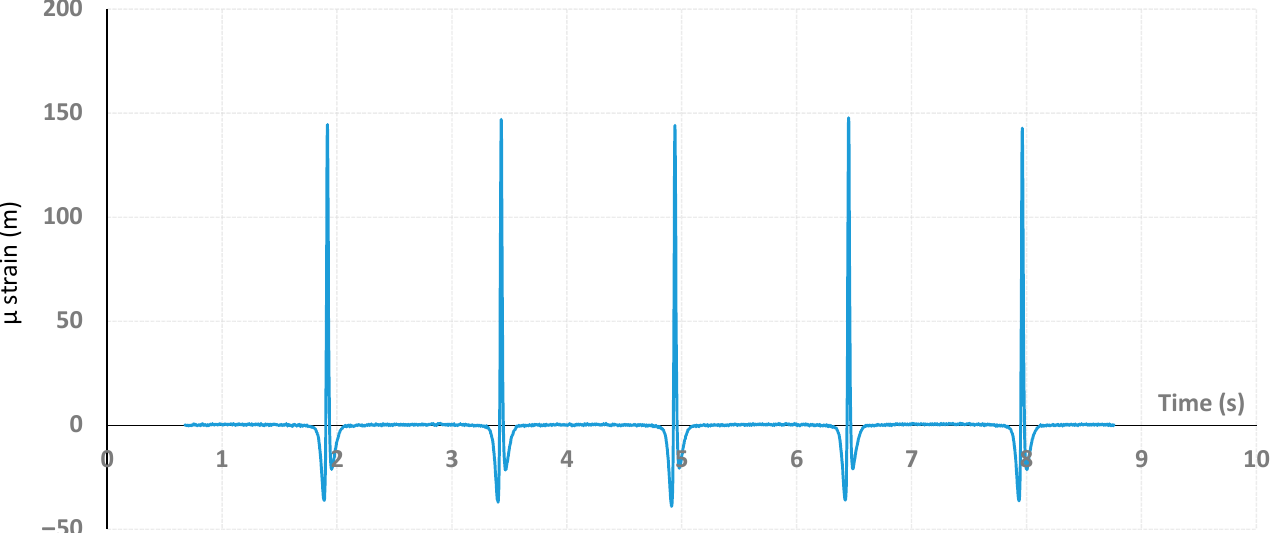
gauge during the spinning cycles. The signal of the gauge (longitudinal strain, given in µ strain, corresponding to the strain value multiplied by 10 − 6 ) consists of a measurement as a function of time of the strain that reached its maximal value (peak, indicating an extension of the gauge) each time that a dual-wheel load passed above the sensor, as pictured in Figure 4.